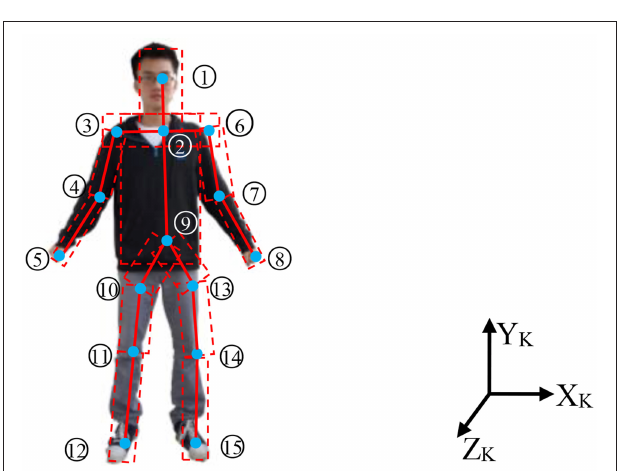
FIGURE 2 | Skeleton joint points in the 3D space. (The person is Dolin and he consents for the Publication of the Manuscript.) 1, Head; 2, Shoulder center; 3, Right shoulder; 4, Right elbow; 5, Right wrist; 6, Left shoulder; 7, Left elbow; 8, Left wrist; 9, Hip center; 10, Right hip; 11, Right knee; 12, Right foot; 13, Left hip; 14, Left knee; 15, Left